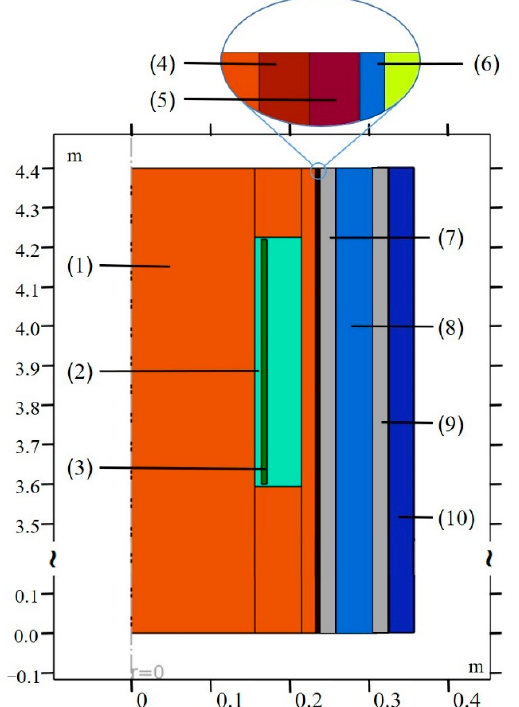
Figure 2. Configuration of the pipe: (1) oil; (2) pig; (3) induction coil; (4) wax layer; (5) nanopaint; (6) inner thermal insulation layer; (7) inner steel pipe; (8) outer thermal insulation layer; (9) outer steel pipe; (10) seawater.